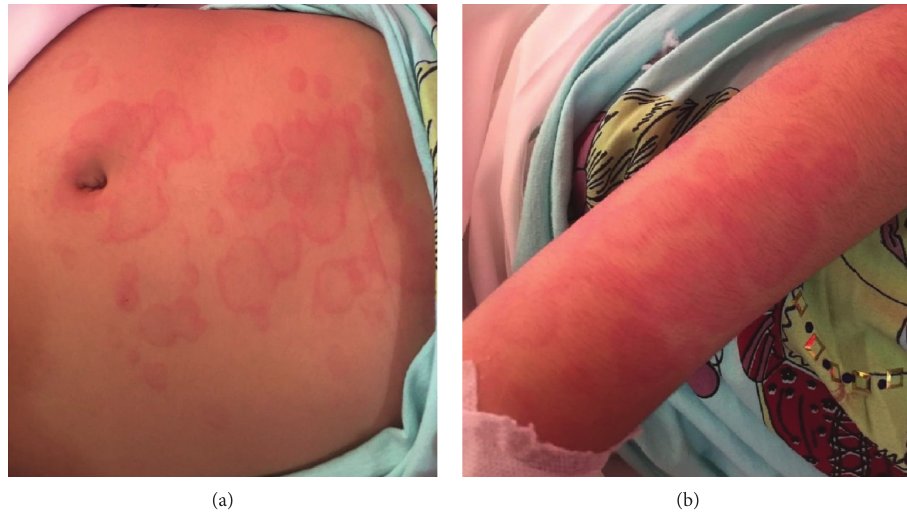
Figure 1: Erythematous multiform rash on the (a) abdomen and (b) upper extremity of a 7-year-old girl with atypical Kawasaki disease. Table 1: Laboratory information on admission of a 7-year-old girl in favor of multisystem inflammatory syndrome with features of atypical Kawasaki disease.